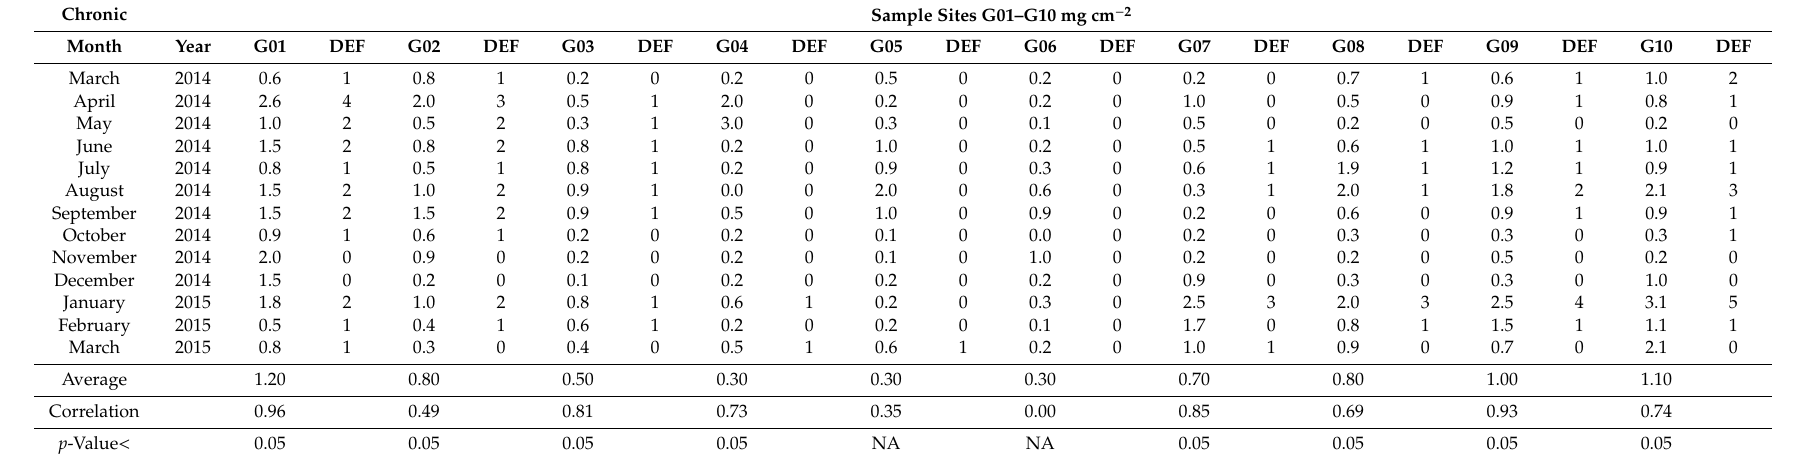
Table 5. Dust Deposition Rates vs.